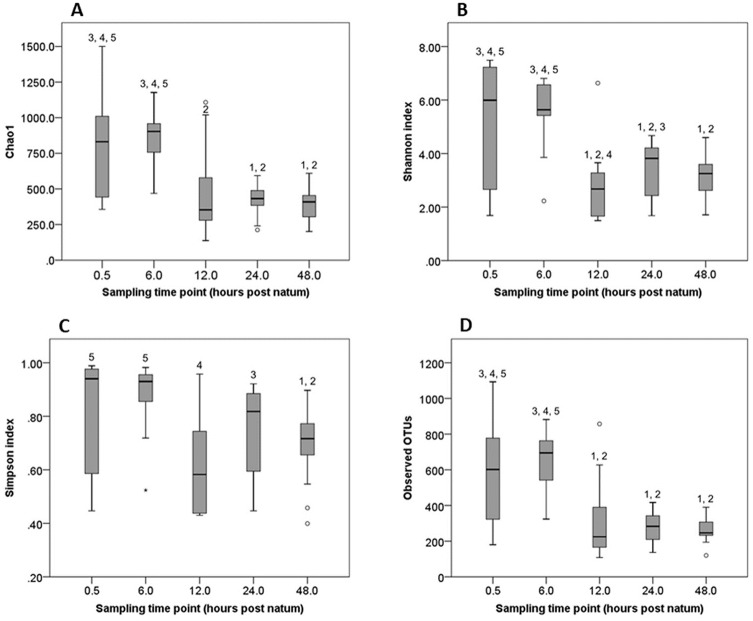
(A) Species richness (Chao1), (B) Shannon and (C) Simpson diversity index and (D) number of observed OTUs in calf faeces during the five sampling time points.Data are visualized as box-and-whisker plots showing the median and the interquartile (midspread) range (boxes containing 50% of all values), the whiskers (representing the 25 and 75 percentiles) and the extreme data points. Numbers above boxes indicate significant differences to the time points.